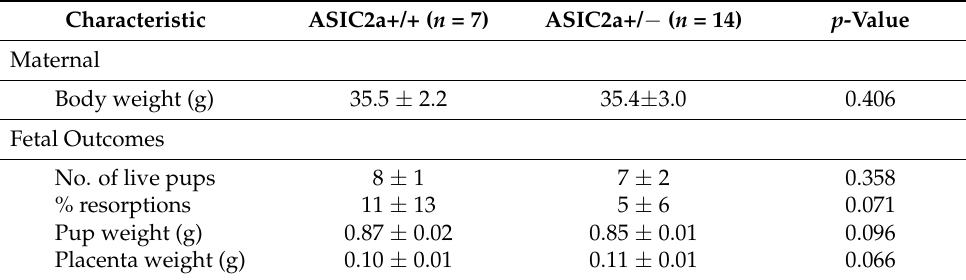
Table 2. General characteristics and pregnancy outcomes in ASIC2a mice at GD18.5.